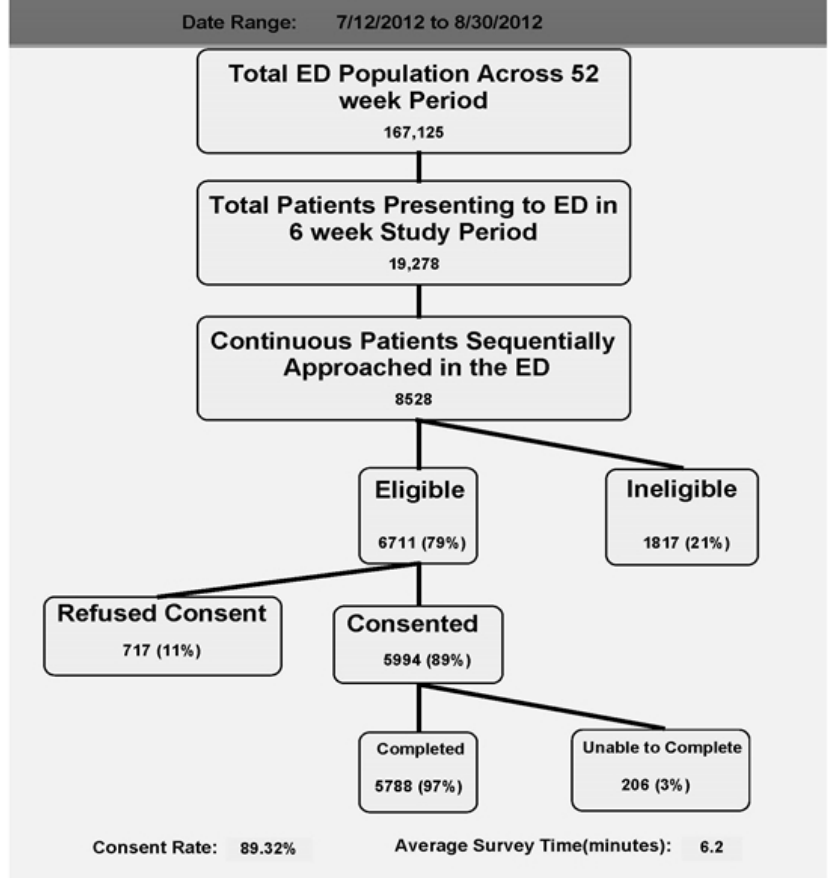
Figure 1. Patient flow